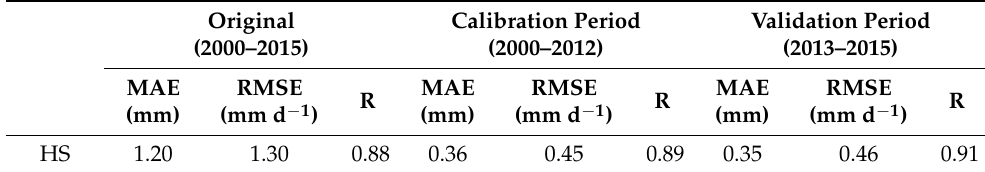
Figure 4. ( a , b ) The ET 0 calibration and validation of the HS model. Table 3. Statistical indices of ET 0 calculated by the HS model.